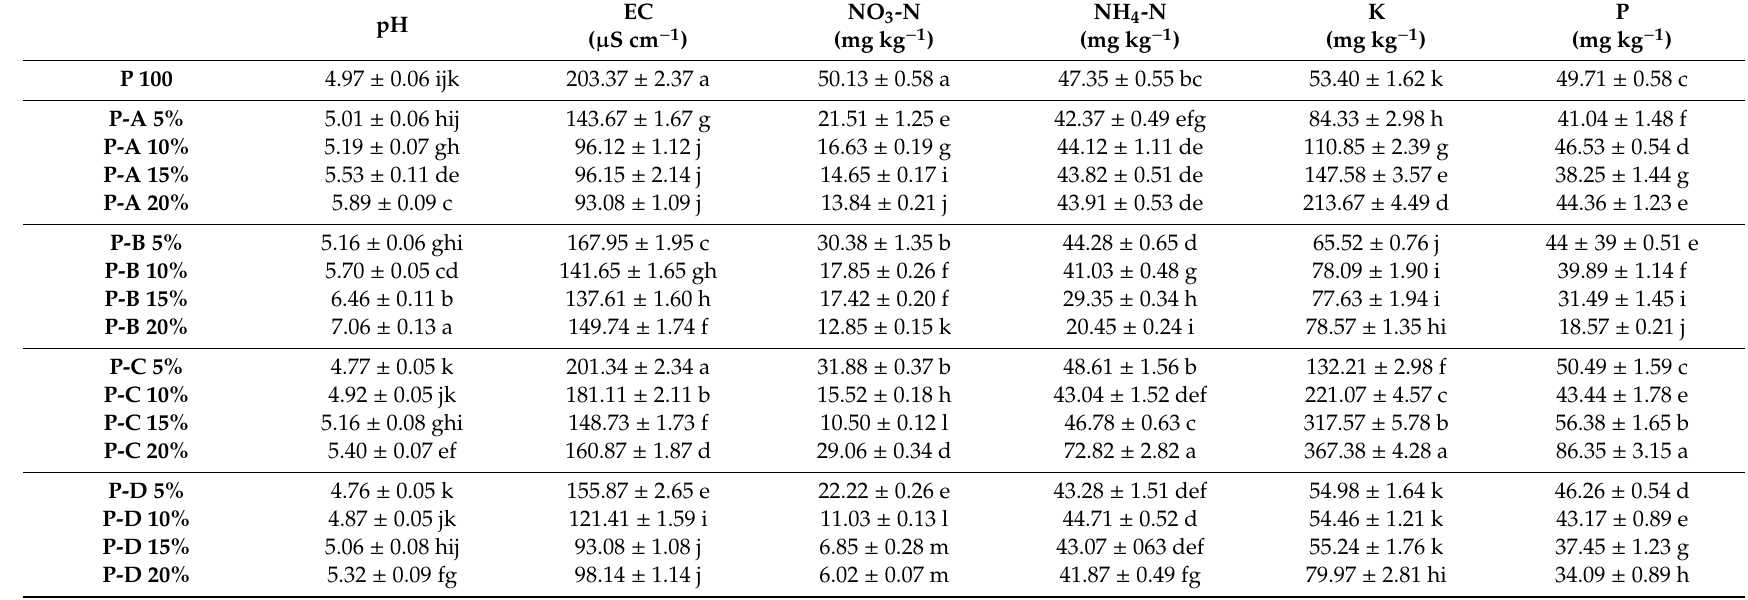
Table 1. E ff ects of peat (P 100) with di ff erent biochar types (A, B, C, D) and ratio (0-5-10-15-20%) on substrate chemical